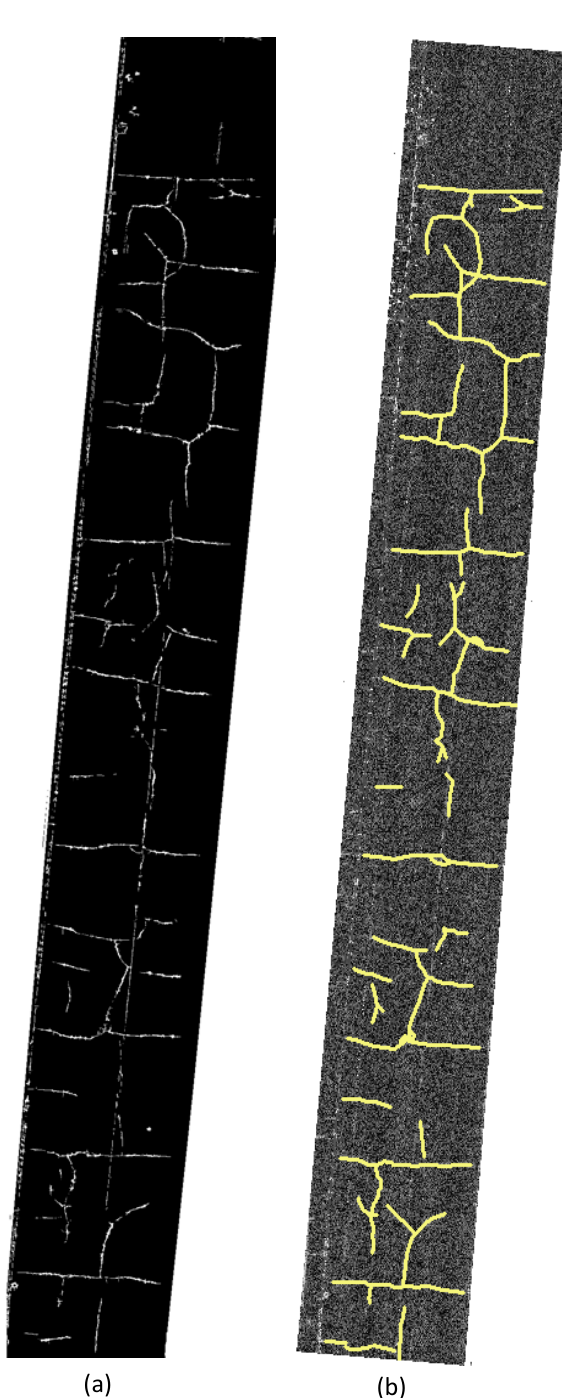
Figure 8. Results obtained by the proposed method: (a) detected cracks containing the whole road segment, (b) ground truth.